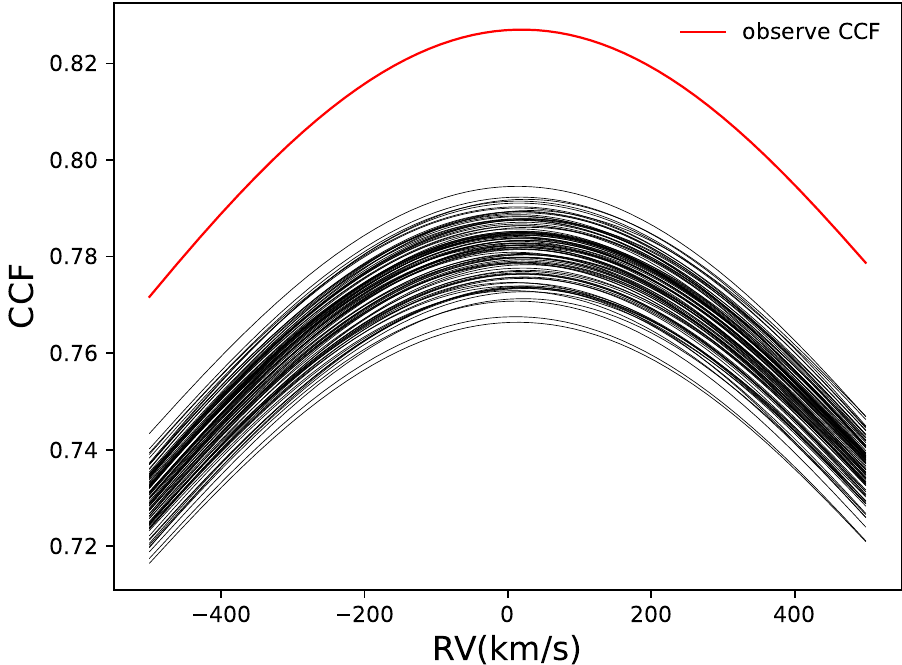
Figure 3. CCF curves of 100 simulated spectra (black line) and CCF curves of observed spectra (red